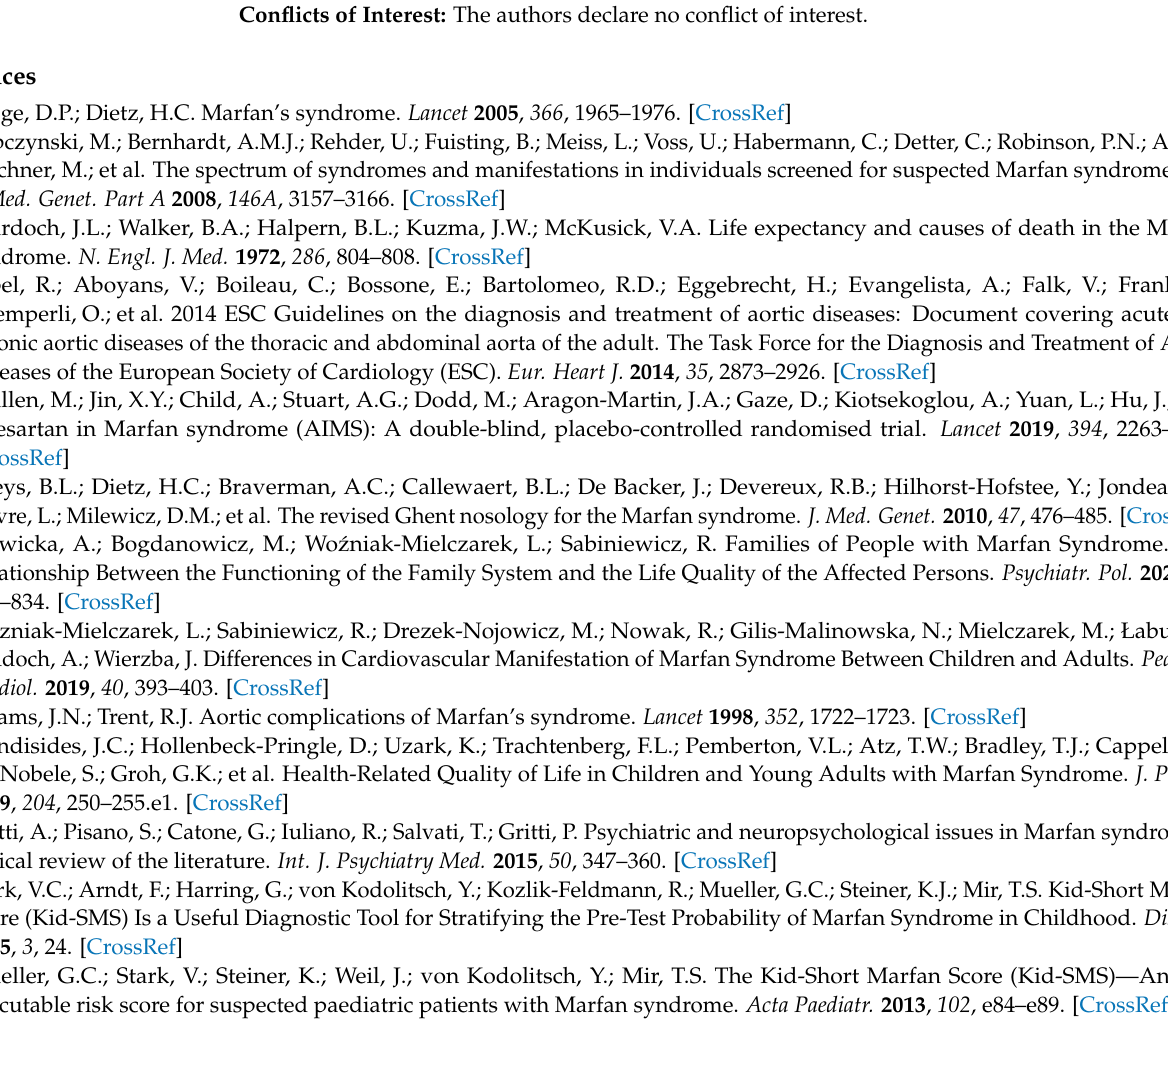
Table S7: Comparative analysis of the most frequently reported symptoms, physical examination abnormalities and other more frequently noted abnormalities between patients with Marfan syndrome and marfanoid habitus in the group of adult men. Table S8: Comparative analysis of the most frequently reported symptoms, physical examination abnormalities and other more frequently noted abnormalities between patients with Marfan syndrome and marfanoid habitus in the group of adult